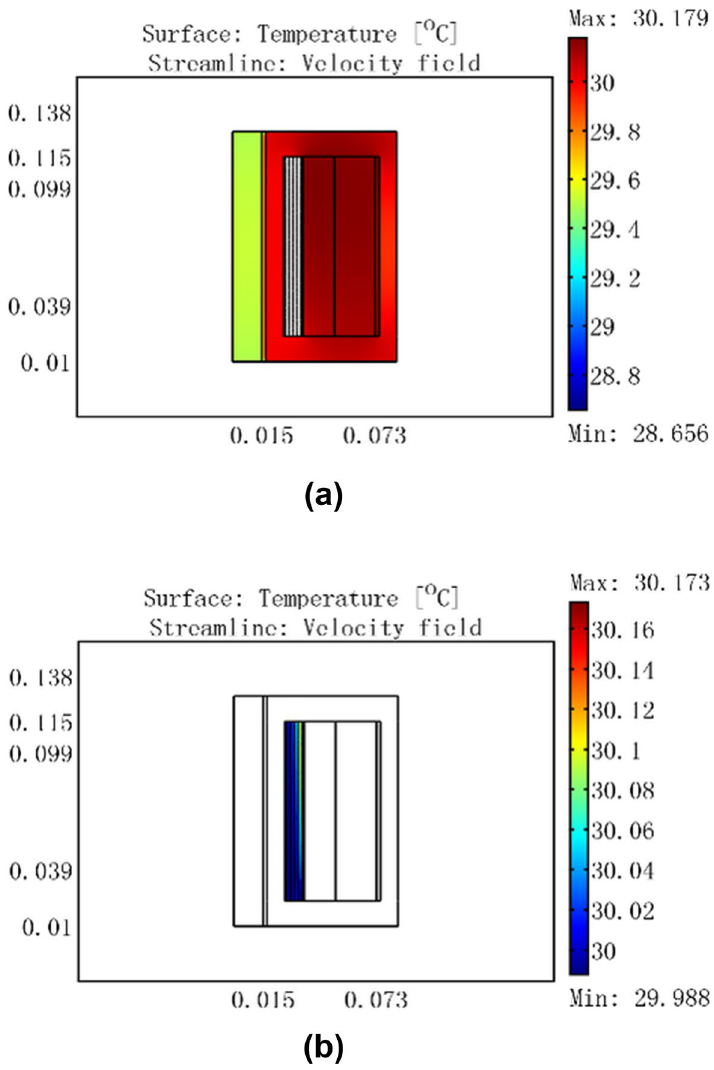
Figure 9. Temperature distribution of GMM smart component for a current of 3 A, cooling water temperature of 30 °C, and flow rate of 0.0464